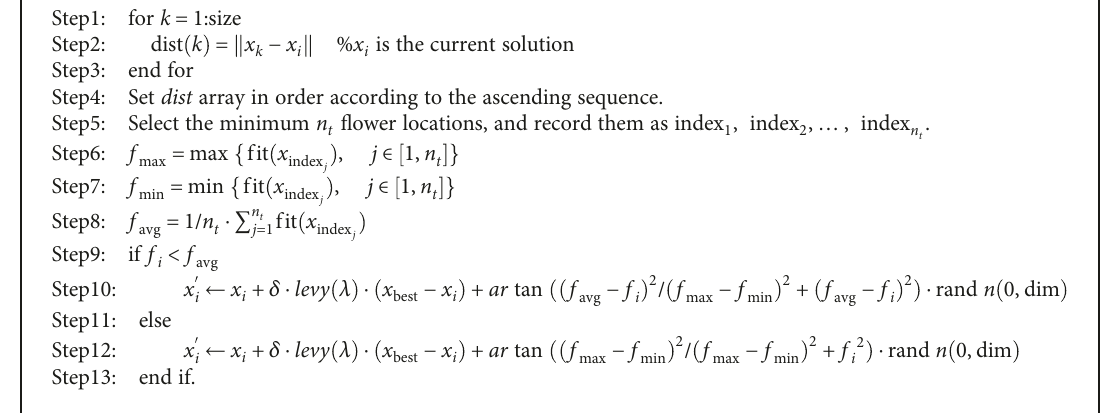
Algorithm 1: The pseudo code of the cross-pollination operator based on hormone modulation mechanism.